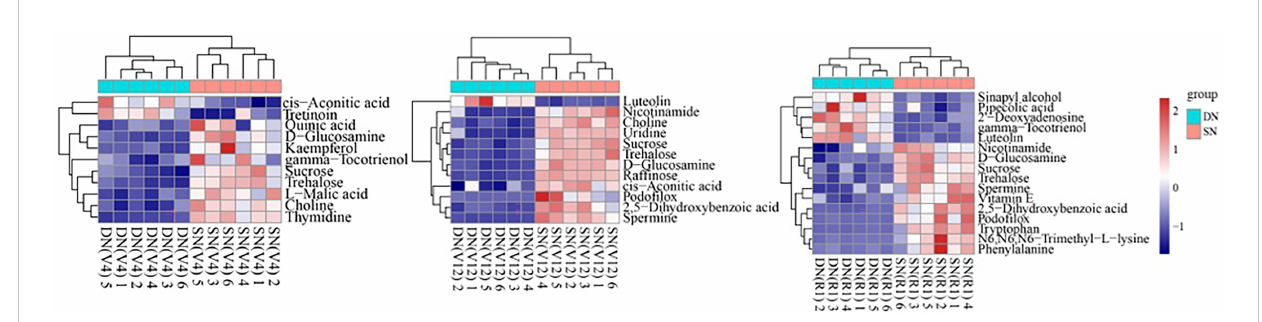
FIGURE 5 Cluster heatmap of major KEGG pathway metabolites in secondary metabolism. Each row represents a differential metabolite (i.e., metabolites with signi fi cant differential expression in the vertical coordinate), and each column represents a set of samples (i.e., sample information in the horizontal coordinate). Red represents signi fi cant upregulation, blue represents signi fi cant downregulation, and the shade of color indicates the degree of up- or downregulation. Metabolites with similar expression patterns are clustered under the same cluster on the left. The left panel shows the KEGG